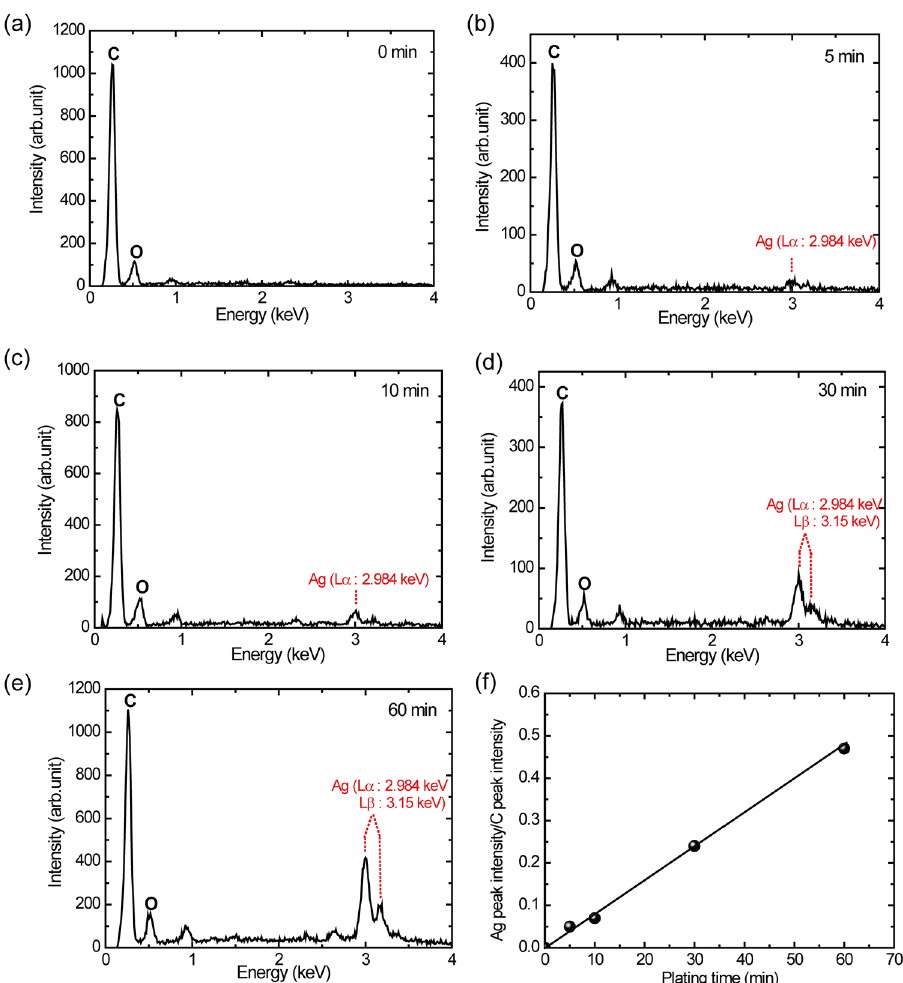
Figure 3. EDX spectrum of the SU-8 surface after electroless silver plating. ( a ) Before plating at t = 0 min. ( b ) After 5 min of plating. ( c ) After 10 min of plating. ( d ) After 30 min of plating. ( e ) After 60 min of plating. ( f ) Plot of the peak ratio between Ag and C as a function of plating